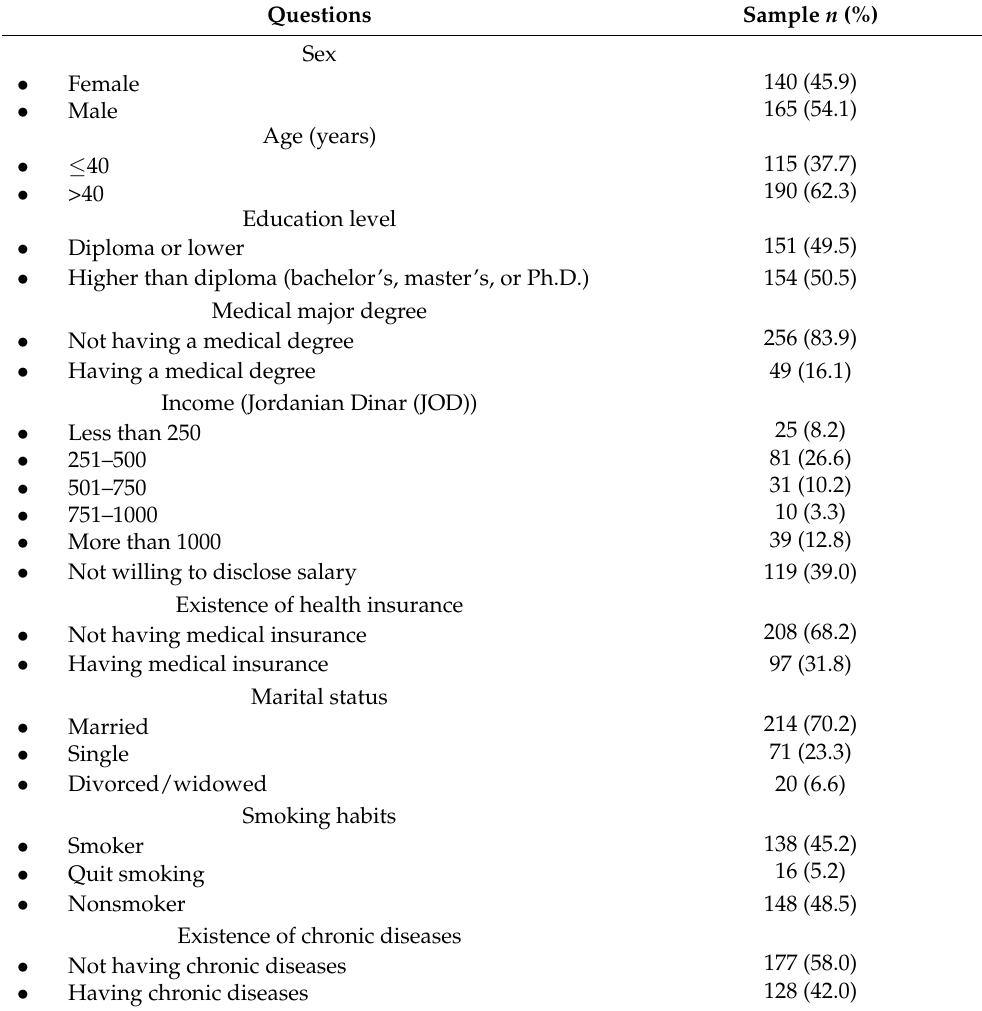
Table 1. General information of the participants ( n =